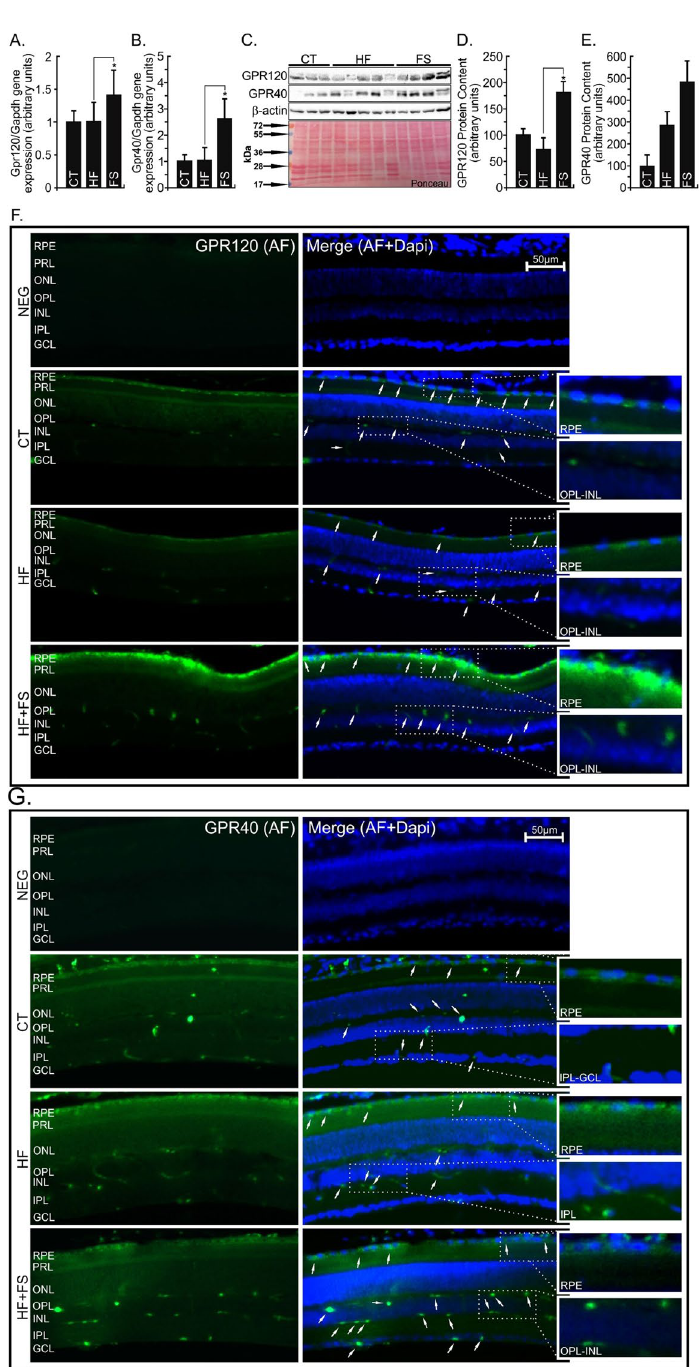
Figure 4. GPR120 and GPR40 Gene Expression, Protein Content and Immunohistochemistry Mapping in the Retina. ( A,B ) Total RNA obtained from retina was used in real-time q-PCR to amplify the mRNAs of GPR120 (A) and GPR40 ( B ). Gapdh was adopted as an internal control. n = 8. ( C–E ) Protein extracts obtained from the retina of Swiss mice were used in immunoblotting (IB) experiments, to evaluate GPR120 and GPR40 protein contents. Specific antibodies against GPR120 or GPR40 were used. Loading was evaluated by re-probing the membranes with anti- β -actin. The images from WB gels are original and did not cropped. Ponceau staining was adopted to improve and guarantee the quality of western blot membrane running. N = 5 per group. # vs. CT. or * vs. HF groups by Bonferroni’s test (P < 0.05). ( F,G ) Retina from Swiss mice fed regular chow (CT), high-fat (HF) or flaxseed oil- (FS) substituted (10%) diet were used in immunofluorescence experiments. Specific antibody against GPR120 or GPR40 (Green AlexaFluor546) was performed in 20- µ m sections of the retina used to identify the respective protein localization targets. The photomicrographs were taken on 50x magnification, and on the 100x highlighted image. AL-Alexa Fluor 546; NEG-Negative control (GPR120 or GPR40 peptide blocking); RPE-Retinal Pigment Epithelium; PRL-Photoreceptor Layer; ONL-Outer Nuclear Layer; OPL-Outer Plexiform Layer; INL-Inner Nuclear Layer; IPL-Inner Plexiform Layer; GCL-Ganglion Cell Layer. White arrows indicate GPR120 or GPR40